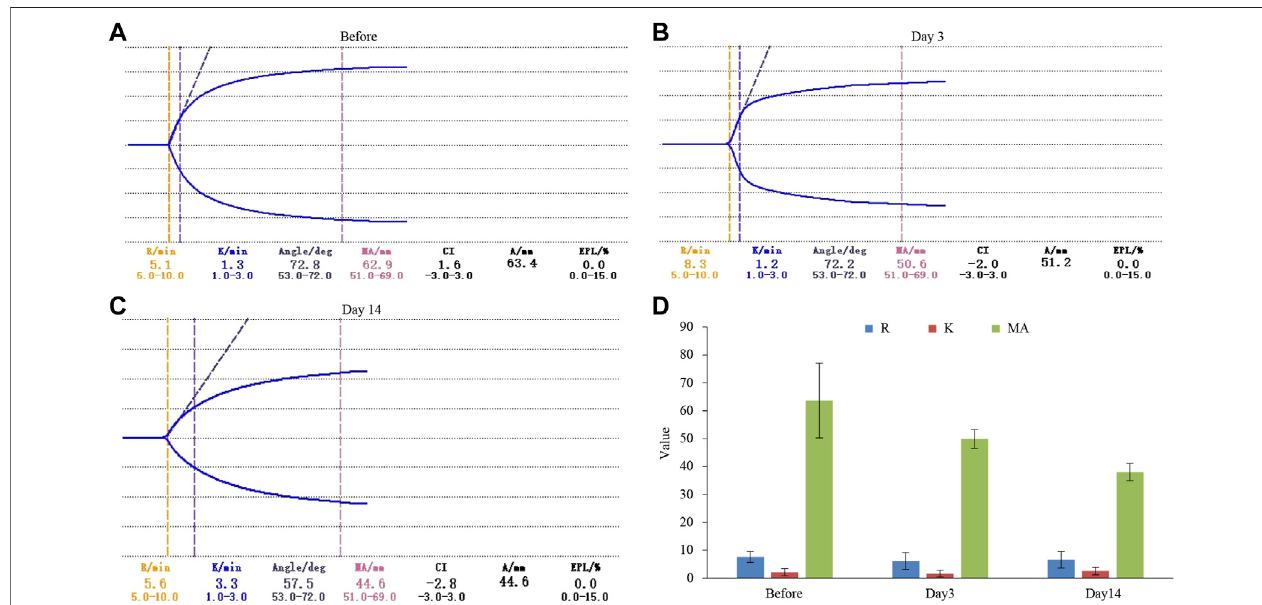
FIGURE2| Thethromboelastographyanalysisofhematologicaltumorpatientswithtigecyclinetreatment. (A) Theresultofthromboelastographyofpatientsbefore using tigecycline. (B) The result of thromboelastography of patients after 3 days of treatment with tigecycline. (C) The result of thromboelastography of patients after 14 daysoftreatmentwithtigecycline. (D) Thestatisticalanalysisofthromboelastographyinpatients( n =10).Reactiontime(R)indicatedthattherewasno fi brinformation in the tested sample; Coagulation time (K) indicated that fi brin began to form in the tested sample, which had a certain fi rmness; The widest distance (MA) on both sides of the curve represented the maximum amplitude of thrombus formation.